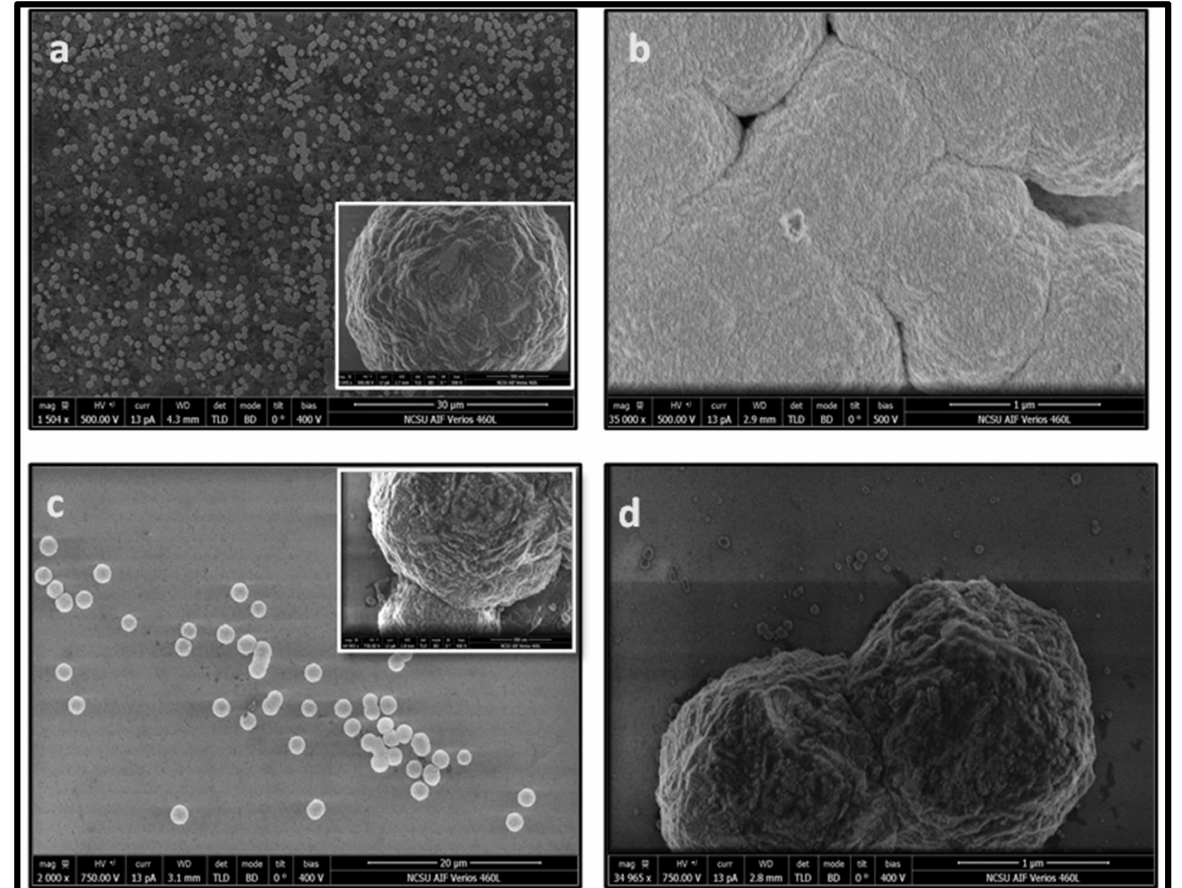
Figure 6. SEM (secondary electron mode) micrographs of diamond film grown by HFCVD method at different magnifications using ( a , b ) Q-carbon seeds, and ( c , d ) diamonds